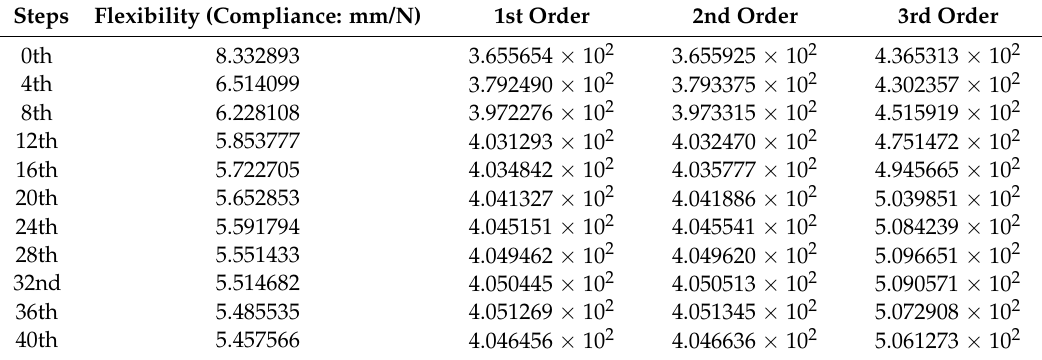
Figure 18. The first order inherent frequency iteration during the multi-objective topology optimization. The multi-objective optimization method obtains 40% of the initial volume ( f 0 = 0.4) at the 40th iteration, and the volume fraction f reaches 0.3836. When f is equal to 0.55, the optimization only needs 26 iterations. Modal shapes of all the remaining elements are displayed in sub-graphs of Figures 15 and 16. The minimum and maximum flexibilities, the first 3 inherent frequencies and modal shape calculated after optimization are shown in Table 4. Table 4. The optimized mechanism flexibility, the first 3 inherent frequencies and the modal shapes recognition (unit: Frequency/Hz).